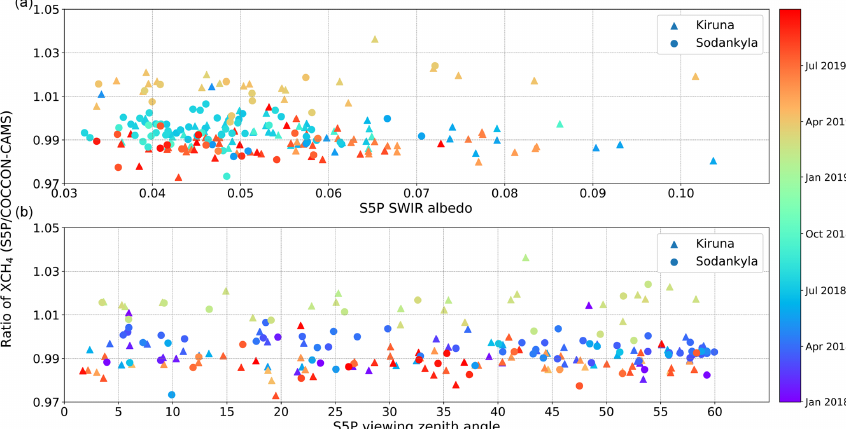
Figure 10. The ratio of XCH 4 (S5P divided by COCCON results) at two different sites as a function of albedo (a) and viewing zenith angle (b) from S5P. It is noted that the color bar starts from 2018 rather than 2017 to distinguish the data